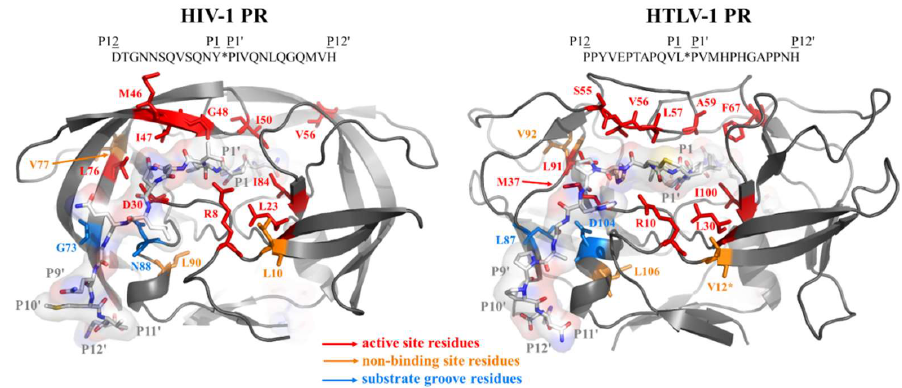
Figure 2. Structures of HIV-1 and HTLV-1 proteases. The modeled structures of HIV-1 and HTLV-1 proteases complexed with substrates representing P12-P12′ residues are shown based on the structural coordinates that were kindly provided by Gary S. Laco [43]. The sequences of the substrates are indicated above the structures. The residues which were modified in this study are shown by sticks, the active site residues which constitute S4-S4’ binding pockets are red, the substrate-groove residues are red, while the residues that are not involved in ligand binding are shown by orange color. * The 12th residue of HTLV-1 PR is valine in the represented structure, but the enzyme we studied in this work contains leucine in this position.